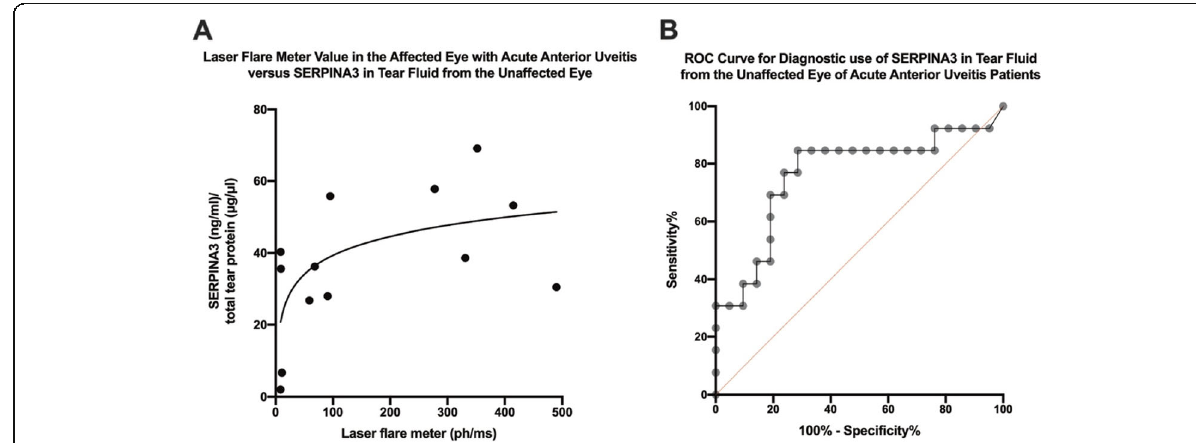
Fig. 3 Serpin Family A Member 3 (SERPINA3) was measured by enzyme-linked immunosorbent assay in tear fluid of the unaffected eyes of patients with unilateral acute anterior uveitis and compared with laser flare meter measurements of anterior chamber inflammation of the affected eyes ( A ). Individual patient values are plotted together with the best fitting logarithmic model (curve) ( R 2 = 0.39; P = 0.022). B A receiver operating characteristic (ROC) curve was calculated to estimate sensitivity and specificity of varying cutoff values for SERPINA3 concentration for detecting patients with unilateral acute anterior uveitis (area under the curve: 0.764; P =